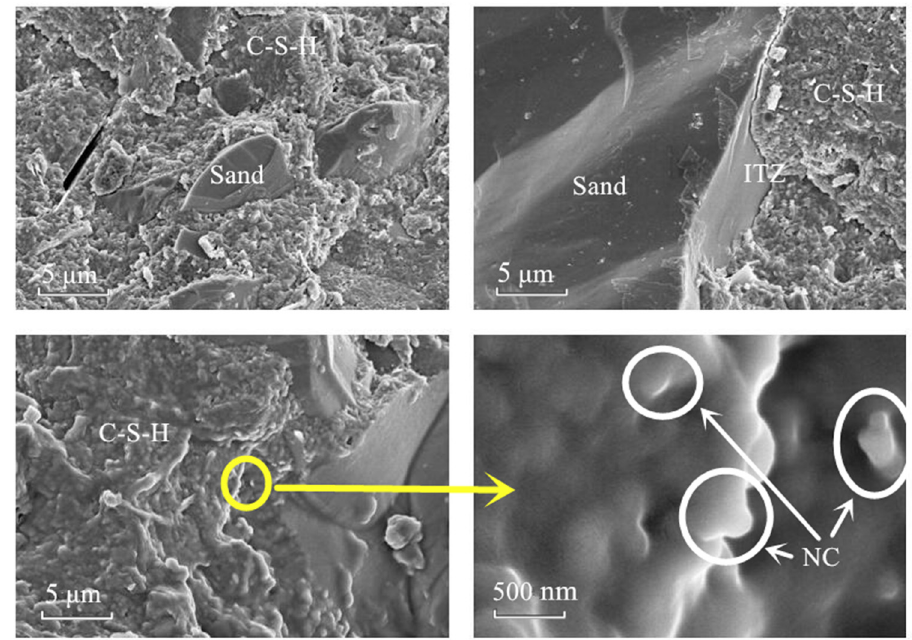
Figure 14: Microstructure of the UHPC with NC at 28